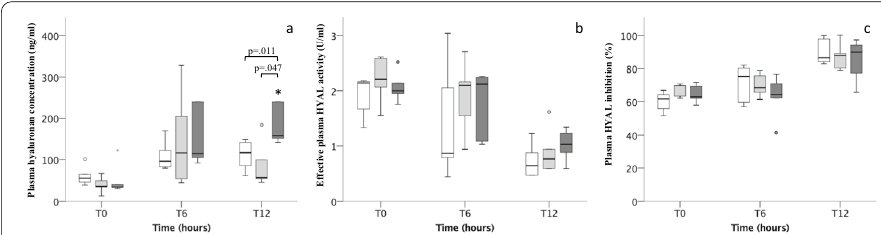
Fig. 2 a – c Preclinical experiments. a Plasma hyaluronan, b effective plasma HYAL activity and c plasma HYAL inhibition for timepoint T0–6–12. a Plasma hyaluronan concentration increased over time in all groups (Control p 0.046, Sepsis-1 and Sepsis-2 p 0.043). b Effective plasma HYAL activity decreased during = = the experiment in all groups (Control p 0.028, Sepsis-1 and Sepsis-2 p 0.043) whereas c plasma HYAL = = inhibition increased significantly in Control and Sepsis-1 over time (Control p 0.028, Sepsis-1 p 0.043). = = Control (white), Sepsis-1 (light gray) and Sepsis-2 (dark gray). p -value from Mann–Whitney U test and